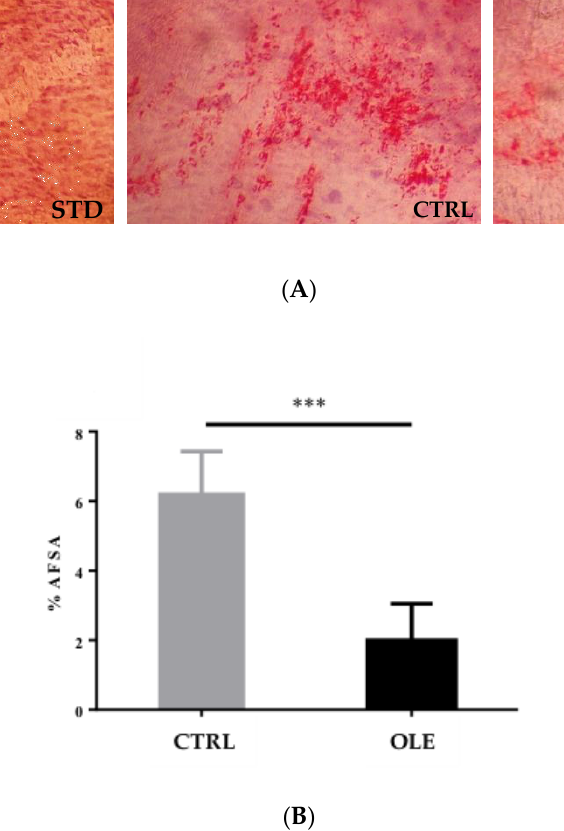
Figure 3. Lipid deposits in the aortic wall of hamsters: Photomicrographs of sections of the surface of the aortic arch stained with Oil Red O ( A ) and aortic fatty streak area (AFSA) to aortic total area (ATA) ratio in hamsters of STD group, CTRL group, and OLE group ( B ). Statistical analysis were performed using the Student’s T -test (*** p < 0.001).